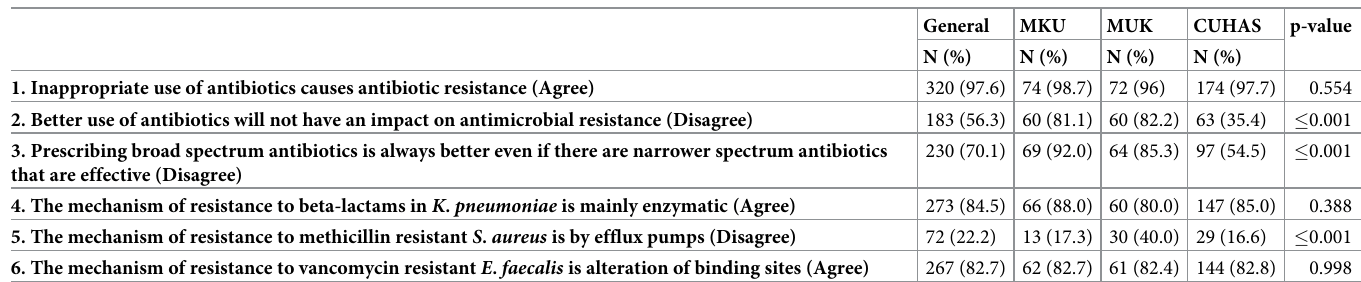
Table 3. Knowledge on antimicrobial